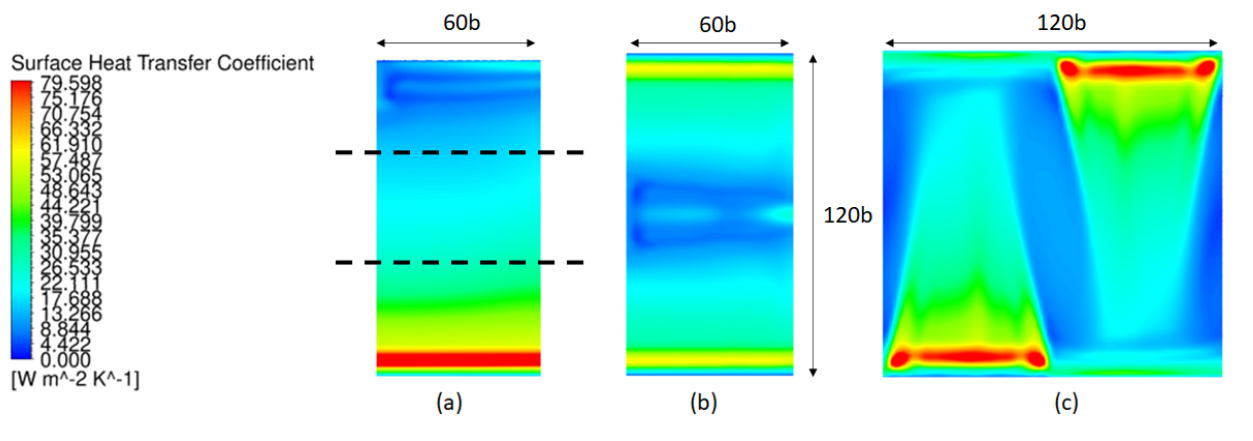
Figure 12. Local heat transfer coefficient at the window top surface (window-RBS interface) for different cooling schemes: ( a ) Scheme A; ( b ) Scheme B; and ( c ) Scheme